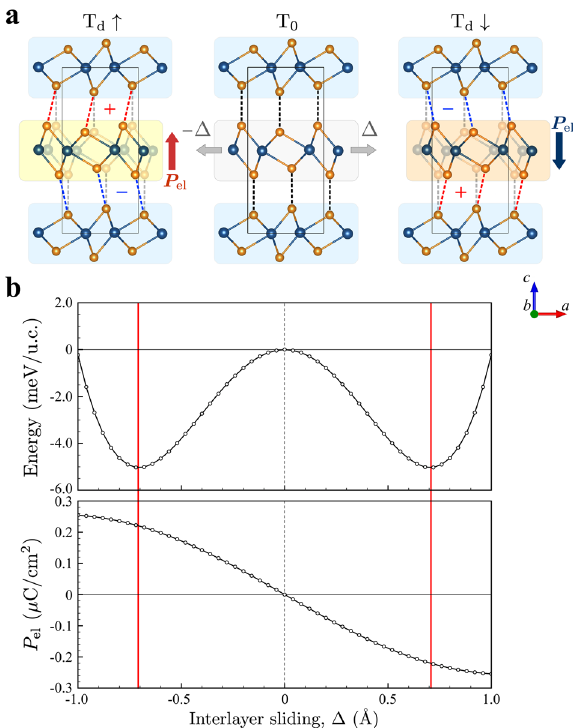
Fig. 2 Ferroelectric polarization in the T d phase of ZrI 2 . a T d ↑ and T d ↓ structures obtained from the devised T 0 phase by interlayer sliding. The M trilayers are denoted with blue rectangles, and the P trilayers with positive and negative sliding displacements are highlighted with orange and yellow rectangles, respectively. b Double-well energy pro fi le and electric polarization along the c axis calculated from the Berry phase theory as a function of interlayer sliding in the devised T 0